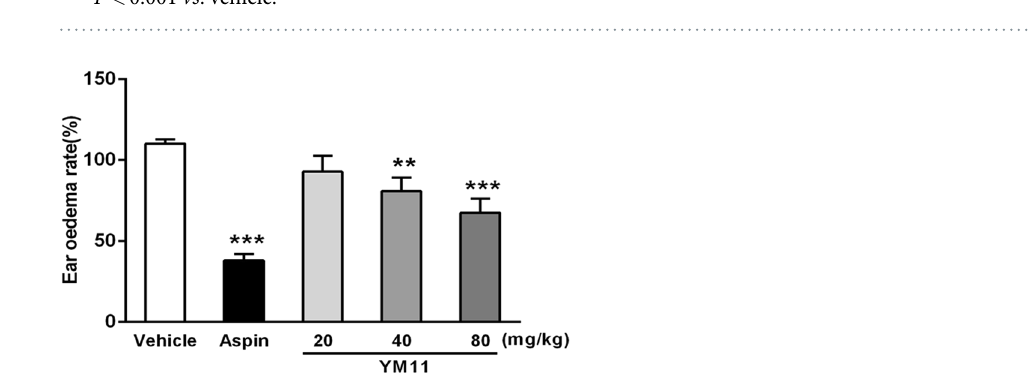
Figure 6. Effect of EESB on xylene-induced ear edema in mice. Results are expressed as mean ± SEM (n = 10). *** P < 0.001 vs . vehicle.